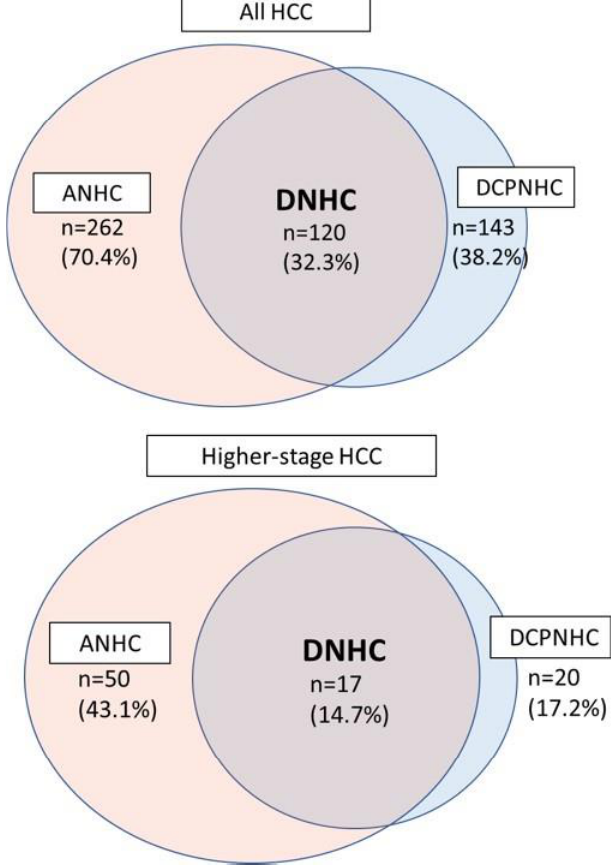
Figure 2. HCC tumor marker negativity. Of all the patients with HCC ( n = 372), 262 (70.4%) were ANHC, and 143 (38.2%) were DCPNHC. DNHC included 120 patients (32.3%). In higher-stage HCC patients ( n = 116), 50 patients (43.1%) were ANHC, 20 patients (17.2%) were DCPNHC, and 17 patients (14.7%) were DNHC. Table 1. Patient